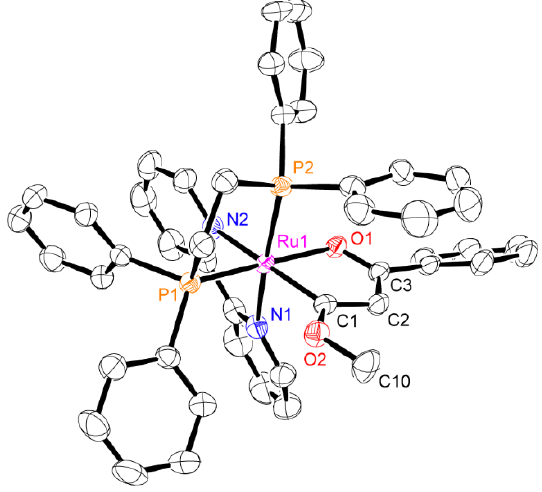
Figure 3. Perspective view of [ 7 ] + as represented by 50% probability ellipsoids (hydrogen atoms are omitted for clarity). Selected bond lengths (Å) and angles ( ◦ ): Ru1–C1 1.982(3), C1–C2 1.393(4), C2–C3